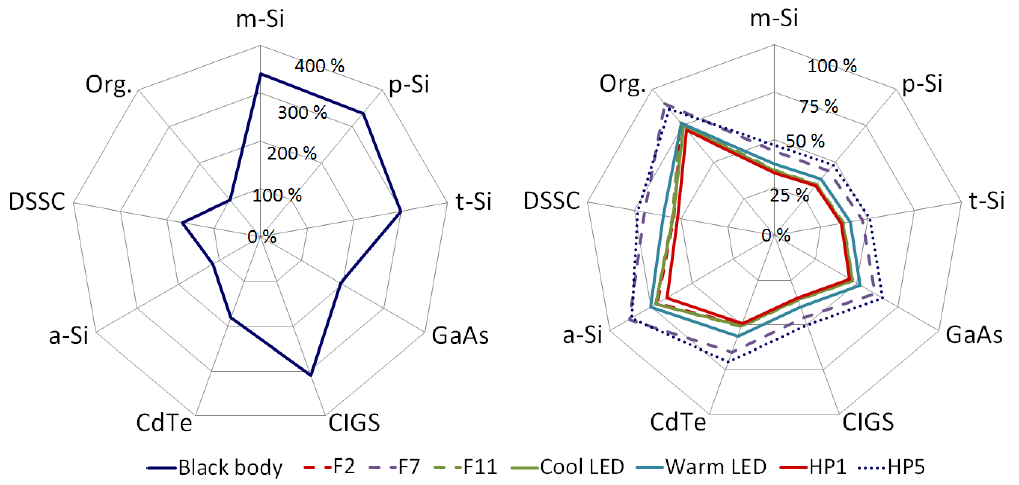
Figure 5. The calculated relative output of the different photovoltaic solar cells under different lighting conditions, compared to the AM 1.5 spectrum as